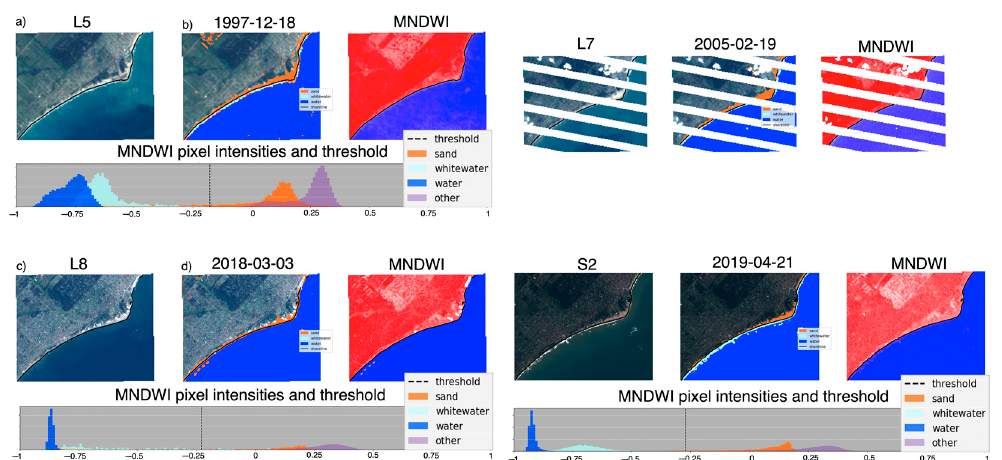
Figure 2. Coastline detection with the CoastSat toolkit for satellite missions ( a ) L5, ( b ) L7, ( c ) L8, and ( d ) S2 at EM and FN. The defined polygon (upper left panel), the pixels labeled in each of the four categories used in the classifier (upper center panel), and the image of the MNDWI index (upper right panel) are present for each satellite mission. The shoreline obtained is shown in each image (black line). The MNDWI pixel intensities and threshold is also shown for each satellite mission (lower panel).